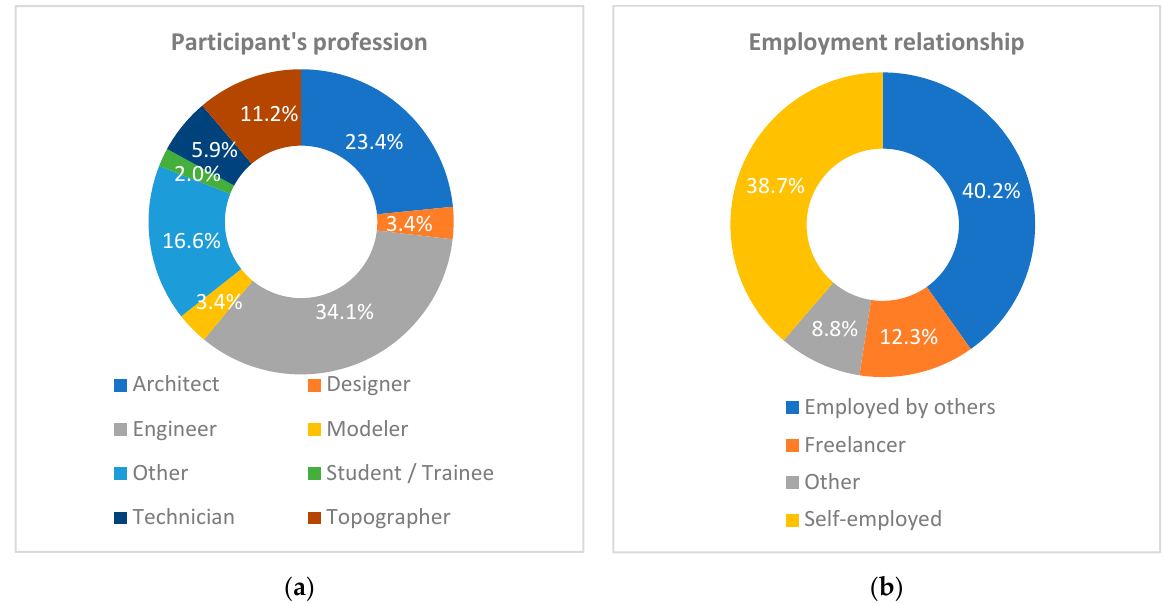
Figure 6. Participant’s professional background. ( a ) Current profession, ( b ) Employment relationship.